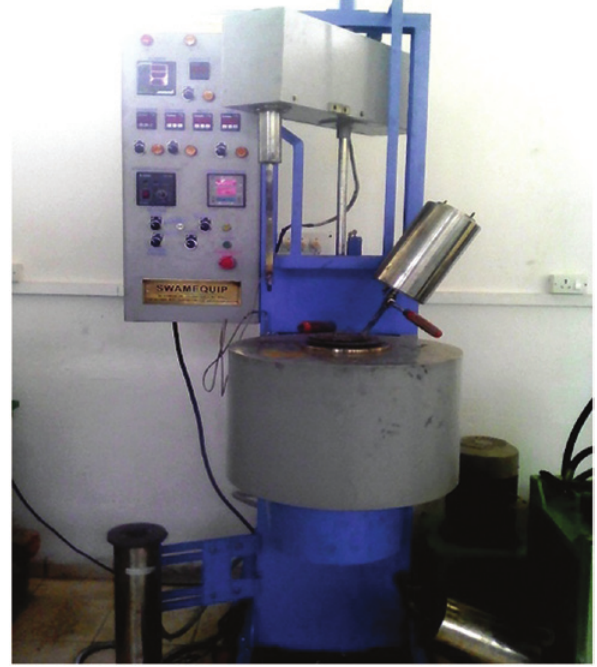
Figure 2: Bottom pouring stir casting apparatus.